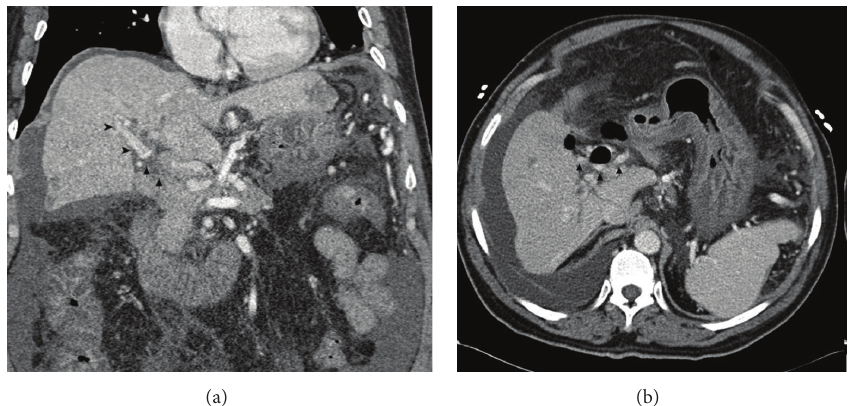
F 1: 62-year-old man with portal vein thrombosis with cavernous transformation. Preprocedural coronal CT image